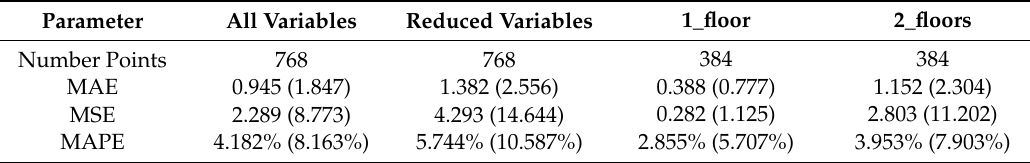
Table 7. Quality parameters for the models of the heating load problem.